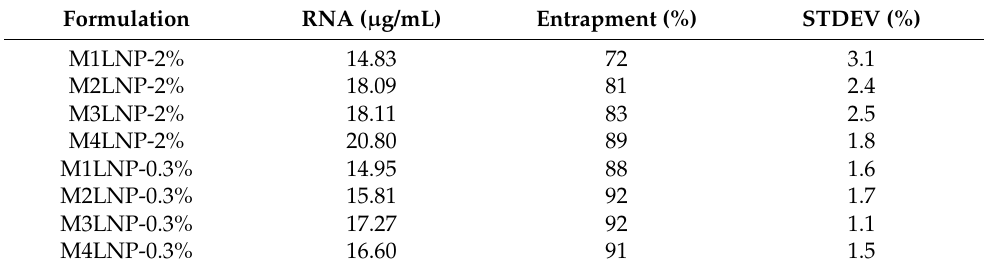
Table 2. Ribogreen assay for quantification of encapsulated RNA in the RSV F SAM-MLNP vaccine.